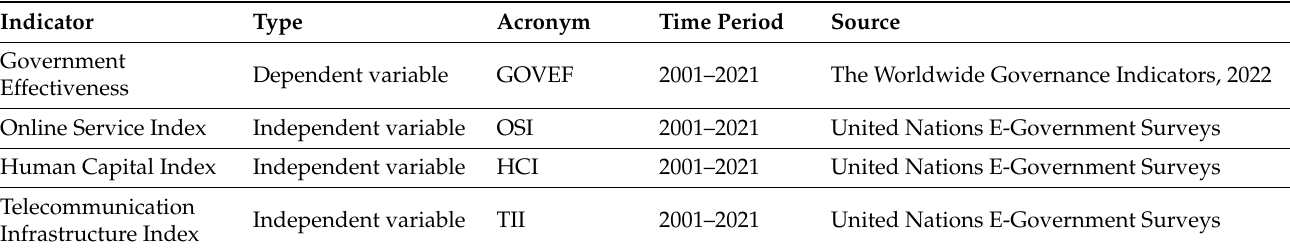
Table 1. Variables included in the